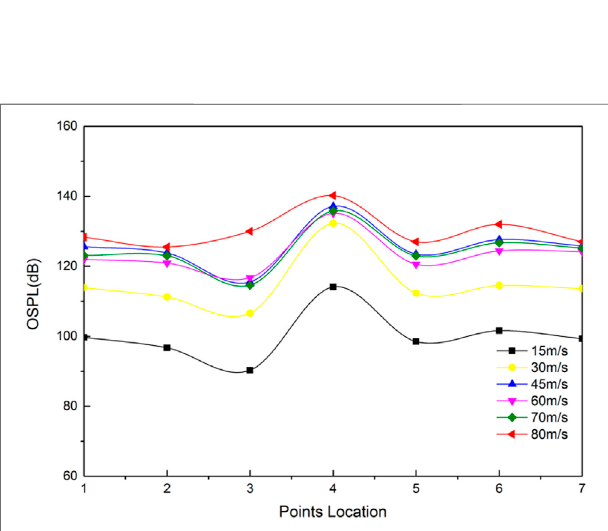
FIGURE 5 | OSPL at different velocities (test